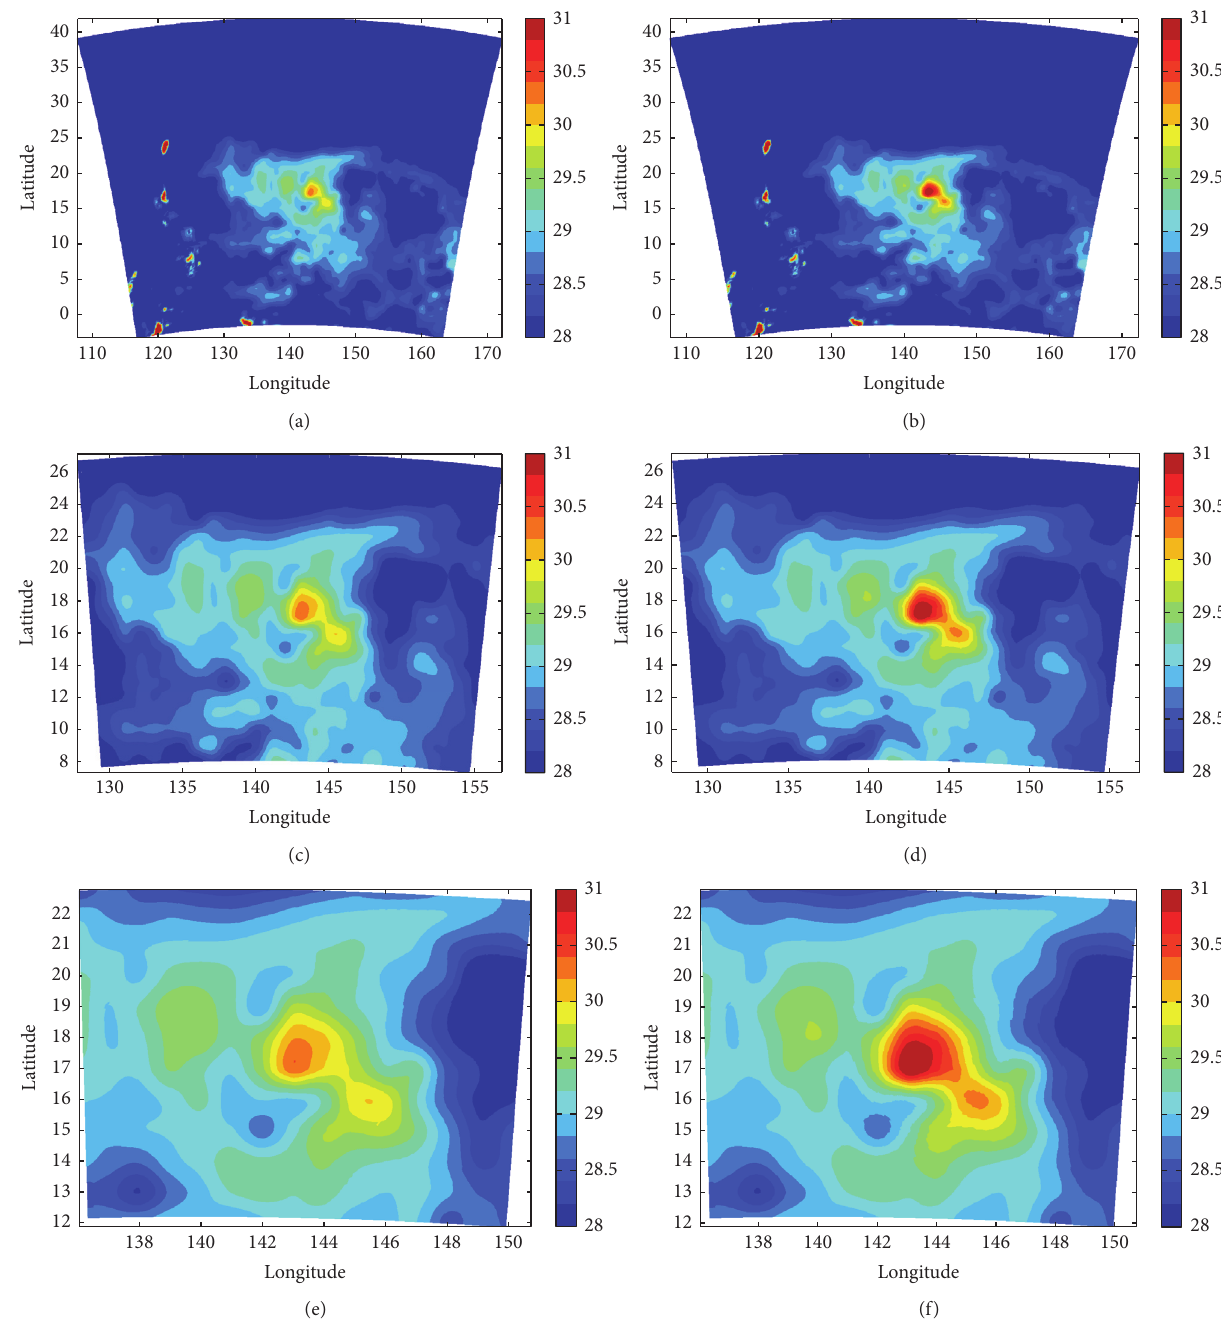
Figure 3: Phanfone: (a) 𝑇 𝑠 before initialization in D01 (27km); (b) 𝑇 𝑠 after initialization in D01 (27 km); (c) 𝑇 𝑠 before initialization in D02 (9km); (d) 𝑇 𝑠 after initialization in D02 (9km); (e) 𝑇 𝑠 before initialization in D03 (3km); and (f) 𝑇 𝑠 after initialization in D03 (3 km). The unit in these figures is ∘